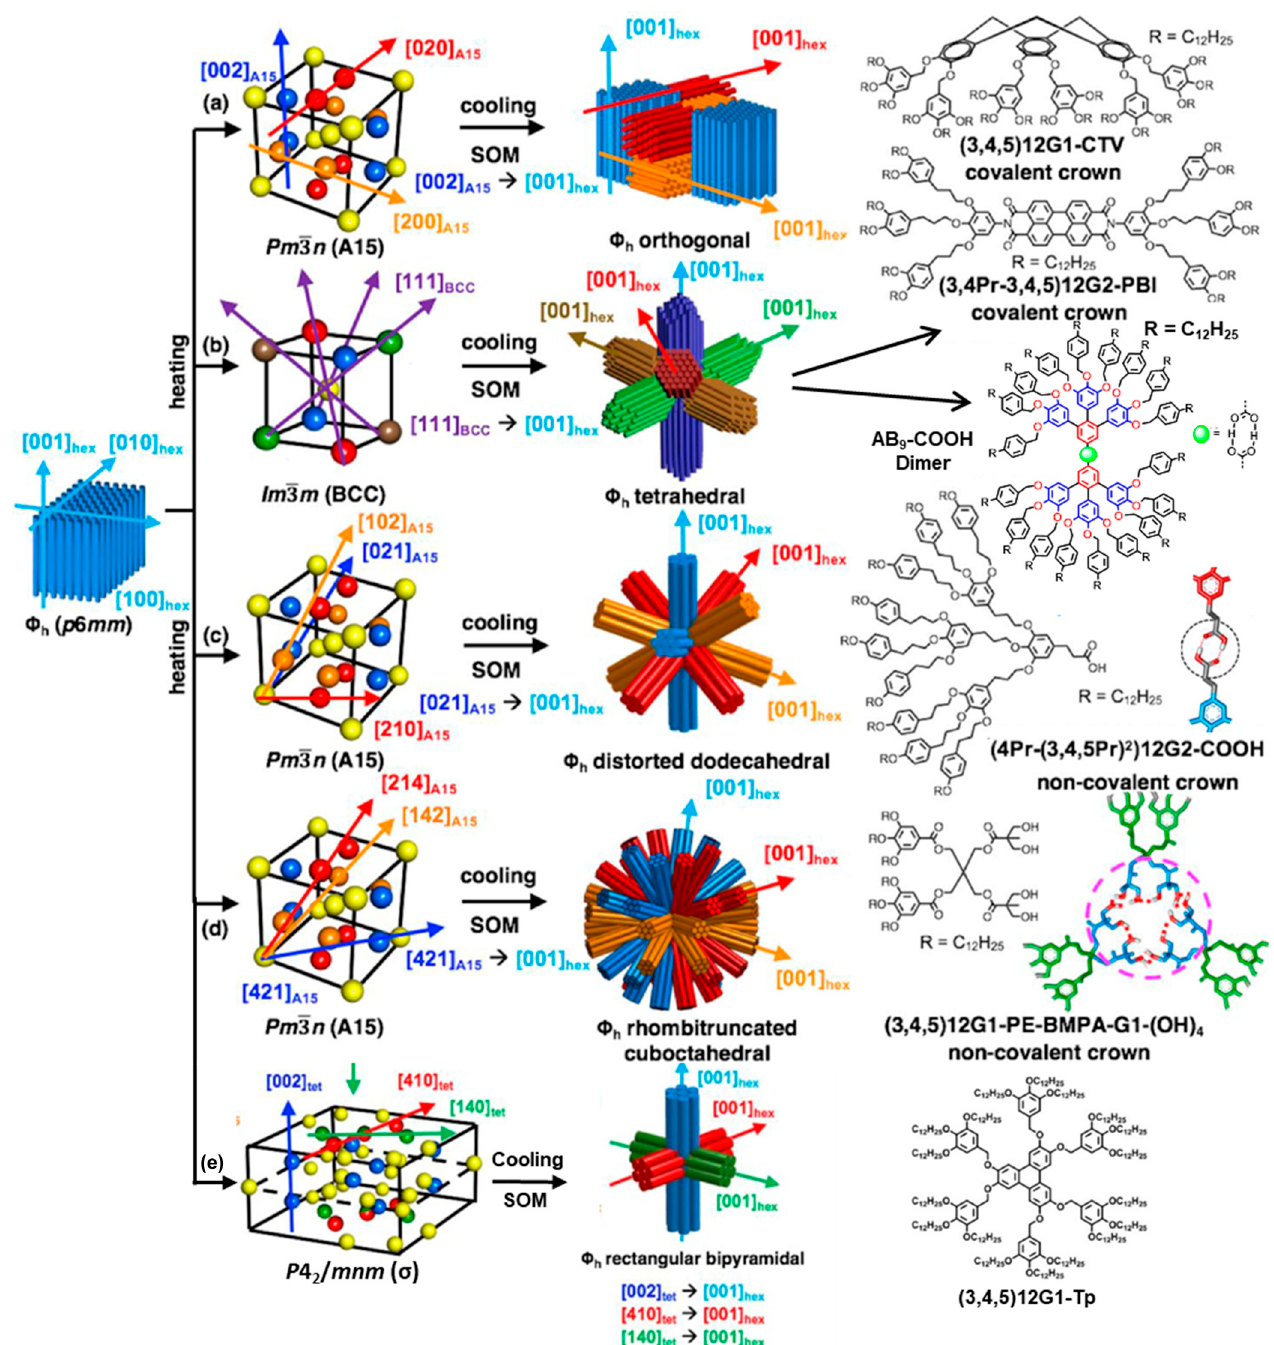
Figure 27. Summary of the supramolecular orientational memory (SOM) effect with selected examples of new bundles of columnar arrays and new molecular bundles of columnar hexagonal arrays generated by SOM [86,179]. SOM from Φ h to ( a ) Pm 3(cid:3364) n (A15); ( b ) Im 3(cid:3364) m (BCC); ( c ) Pm 3(cid:3364) n (A15); ( d ) Pm 3(cid:3364) n (A15); and ( e ) P 4 2 / mnm ( σ ). This Figure is reproduced with permission from [178]. © 2022 The Author(s). Published by Elsevier Ltd.